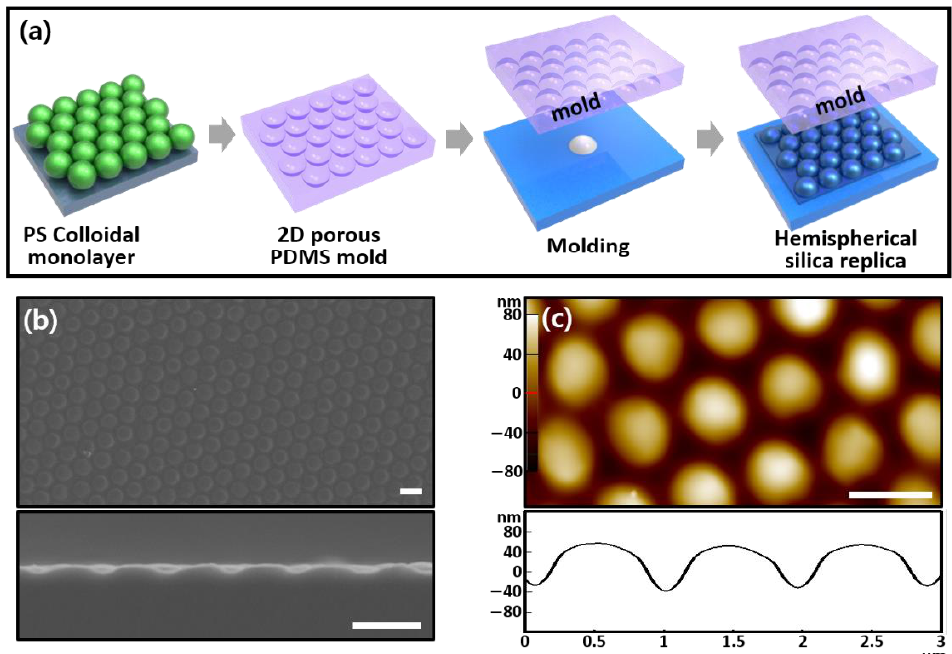
Figure 2. ( a ) The systematic fabrication of the hemispherical silica replica, ( b ) scanning electron microscopy (SEM) (below is a cross-sectional image), and ( c ) atomic force microscopy (AFM) images of well-organized silica colloidal arrays with hexagonally ordered structures and the height profile presented. The scale bars are 1 µm.